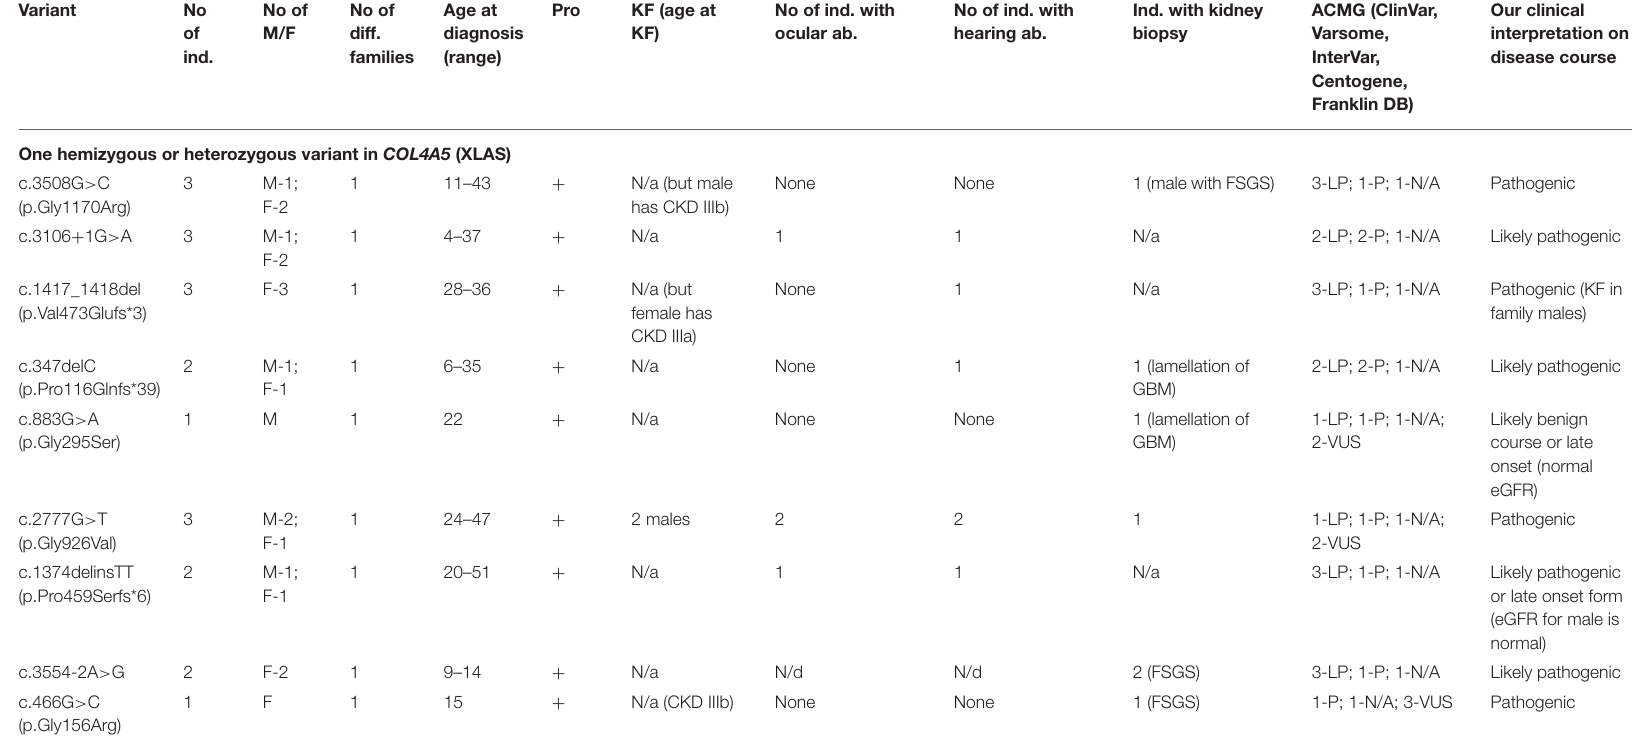
TABLE 4 | Summary of novel COL4A5 variants found in a study (only heterozygous and hemizygous variants with X linked